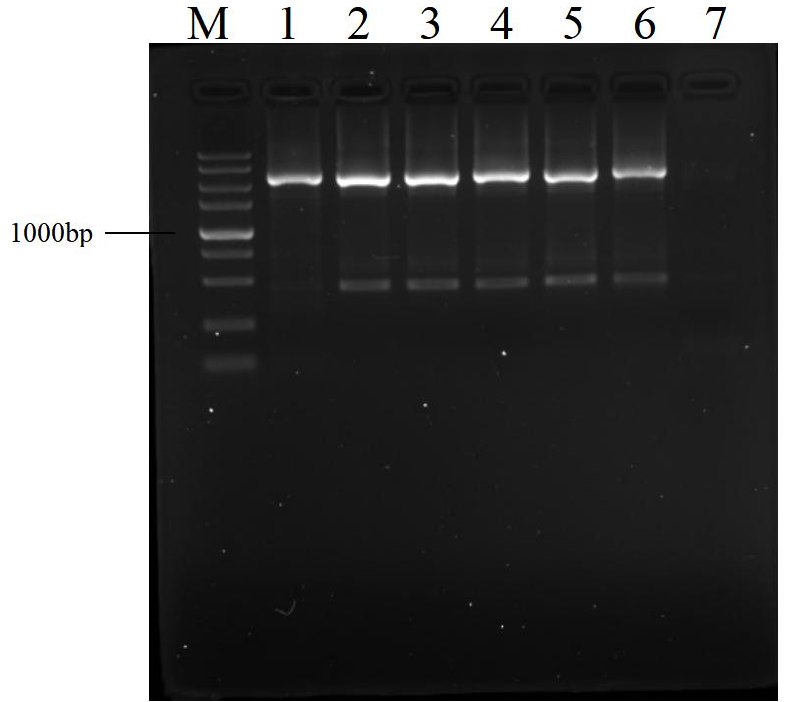
Figure 2. Effects of dilution of primary amplification product on secondary PCR. The amplified target was gadR . The primary PCR was performed as described in Table 2. Lane 1: primary PCR product;